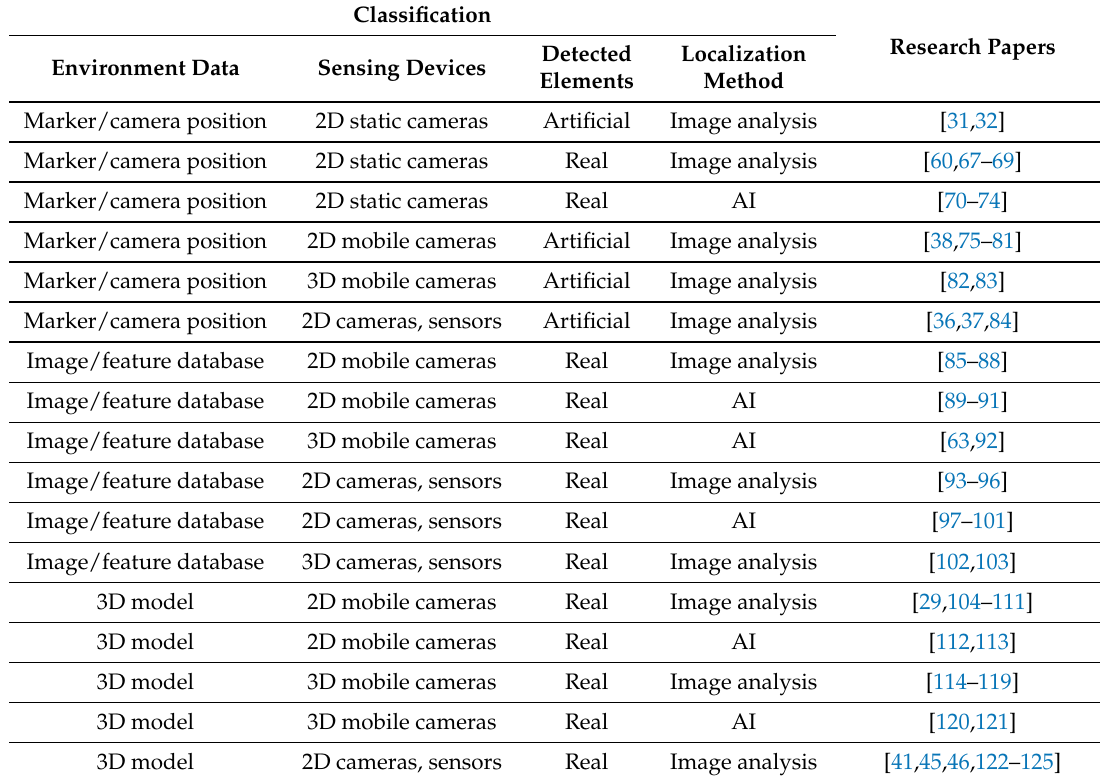
Table 1. Classification of computer vision based localization research papers considering the environment data, the sensing devices, the detected elements, and the localization